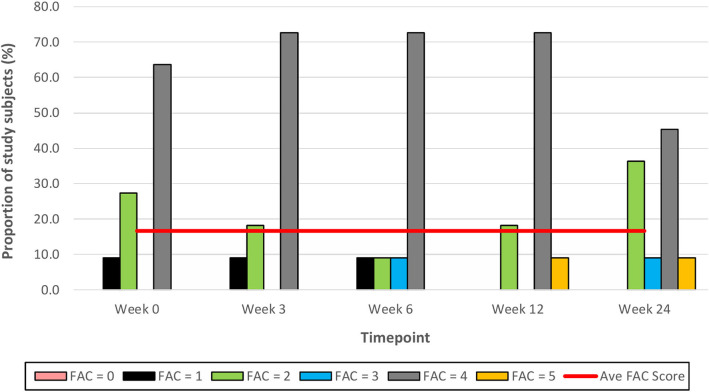
Time series plot showing the secondary outcome measure of Functional Ambulation Category (FAC) score. Each bar represents a FAC score (range 0–5, with 0 representing a non-functional ambulation and 5 representing independent ambulation). A trend line (–) has been superimposed to illustrate the change in the mean ± SD FAC score from baseline pre-intervention (i.e., Week 0) to final follow-up post-intervention (i.e., Week 24).